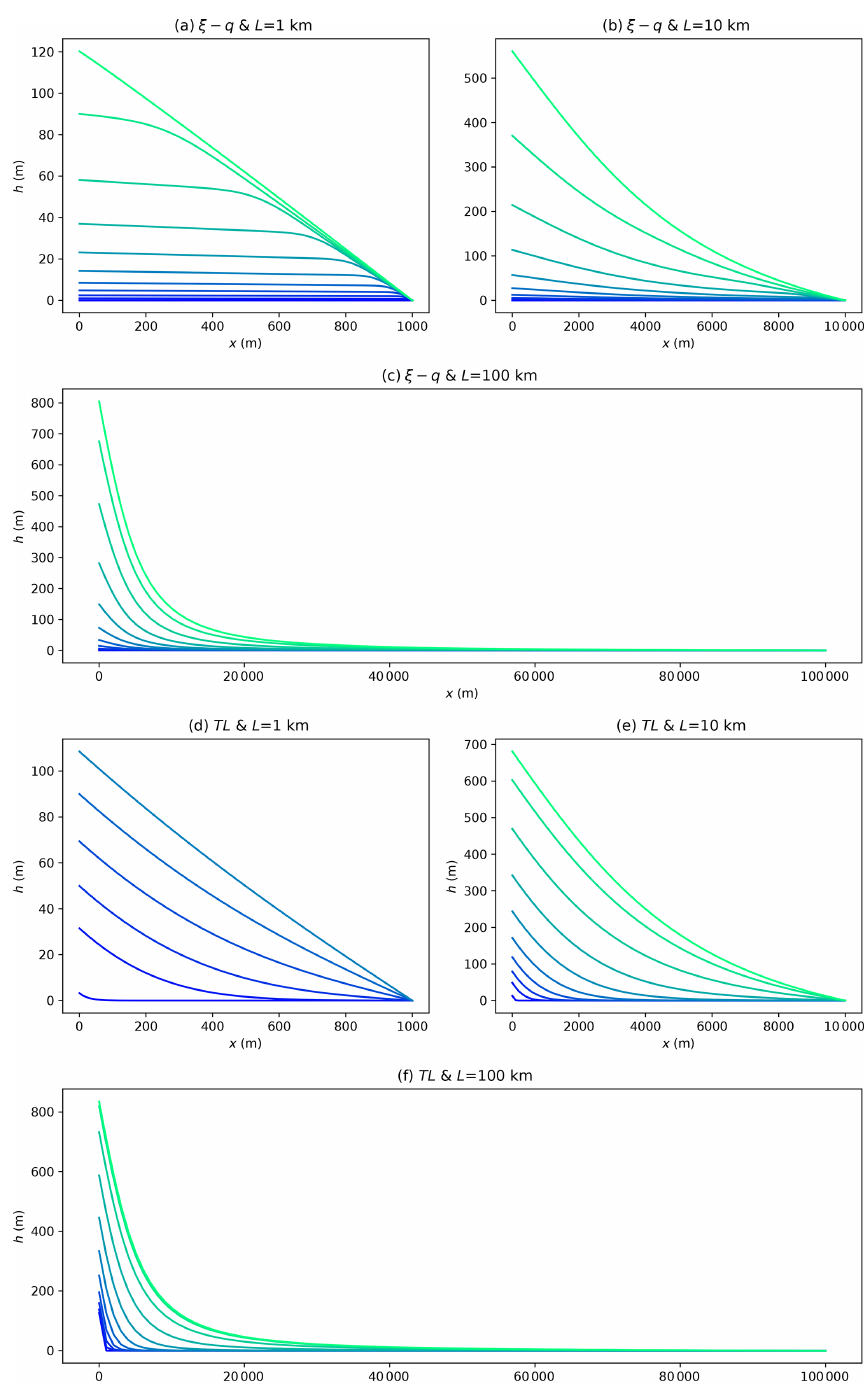
Figure 6. Surface elevation at a series of logarithmically spaced time steps obtained by solving the ξ – q and TL equation for different system length, L , smaller than, equal to or greater than L 0 = 10km. Blue to green colors correspond to early to late time steps.